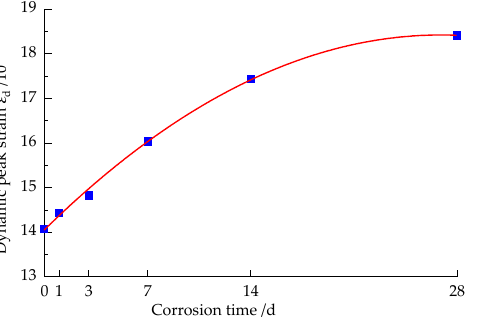
Figure 7. Variation curve of dynamic peak strain with the solution corrosion time.